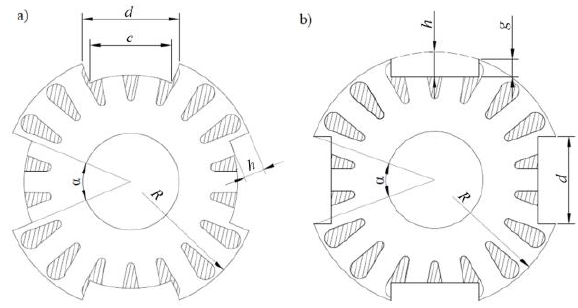
Fig. 2. Rotor of the reluctance motor (a) with an arc cut - W1 and (b) with a flat cut -